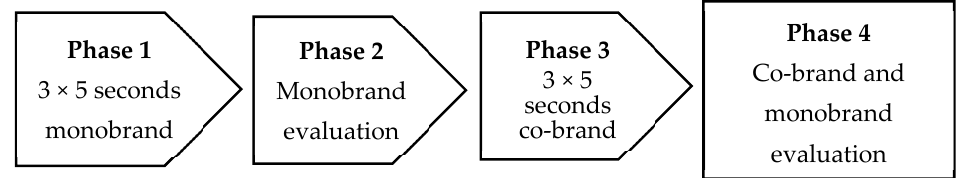
Figure 2. Experimental design of study 1.